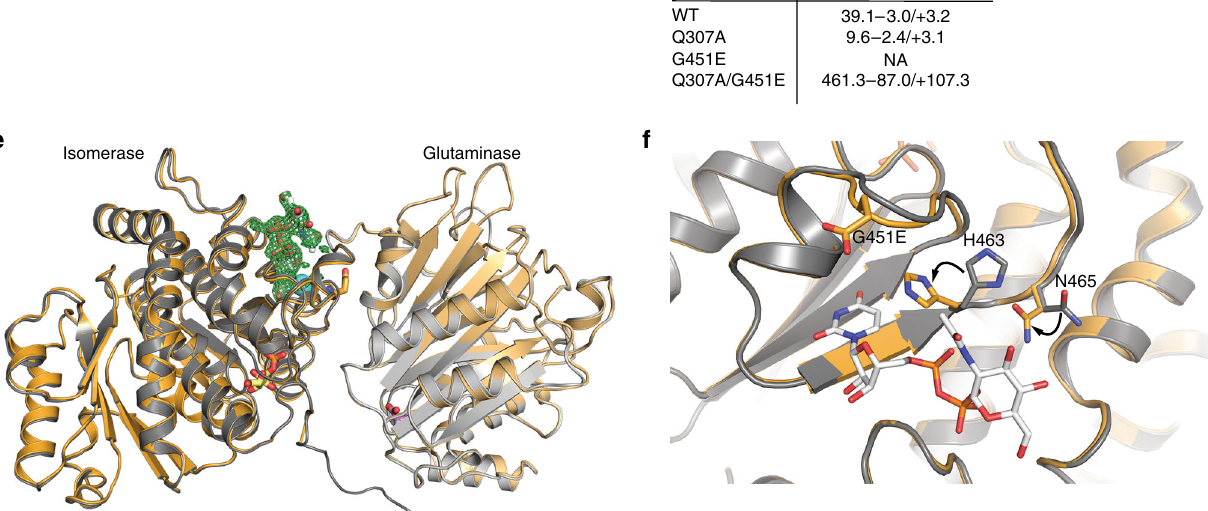
Fig. 5 GFAT-1 gain-of-function mutation perturbs UDP-GlcNAc inhibition. a , b Effect of G451E mutation on GFAT-1 structure. Proteins are presented as cartoons. Superposition of wild type GFAT-1 (light gray/dark gray) and G451E GFAT-1 (yellow/orange). Glc6P (yellow sticks) and L -Glu (violet sticks) are highlighted. a G451E (sticks) is located at the isomerase domain of GFAT-1 pointing towards the interdomain linker (black box). b Superposition of the wild type and the G451E GFAT-1 structure focusing on residues in close proximity to the mutation. c L -Gln kinetic of wild type (WT, black circle) and G451E (red triangle) GFAT-1 (mean ± SEM, n = 5). d Representative UDP-GlcNAc inhibition of wild type (black circle), G451E (red triangle), Q307A (blue triangle), and Q307A/G451E (green square) GFAT-1 (mean ± SD, n = 3). Table: IC 50 UDP-GlcNAc values (mean ± SEM, n = 3). e , f Superposition of UDP-GlcNAc- bound G451E GFAT-1 (yellow/orange) and wild type GFAT-1 in the absence of UDP-GlcNAc (gray). Proteins are presented as cartoons. Glc6P (yellow sticks), L -Glu (violet sticks), UDP-GlcNAc (white sticks), Mg 2 + (cyan sphere), and G451E (sticks) are highlighted. e Overall structure with Fo − Fc omit map (green) of UDP-GlcNAc binding to G451E GFAT-1 at a contour level of 3.0 RMSD. f Close-up of the UDP-GlcNAc-binding pocket with local side chain movements in G451E GFAT-1. Source data are provided as a Source Data fi